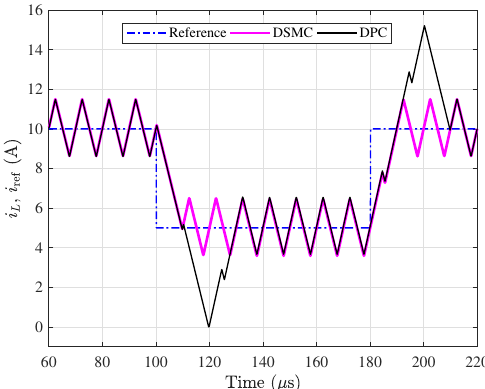
Figure 8. Comparison between the inductor current response corresponding to the predictive control and the DSMC. Under the DSMC, the inductor current reaches its reference in one switching/ sampling cycle. Under the predictive control, the inductor current reaches its reference in two switching/ sampling